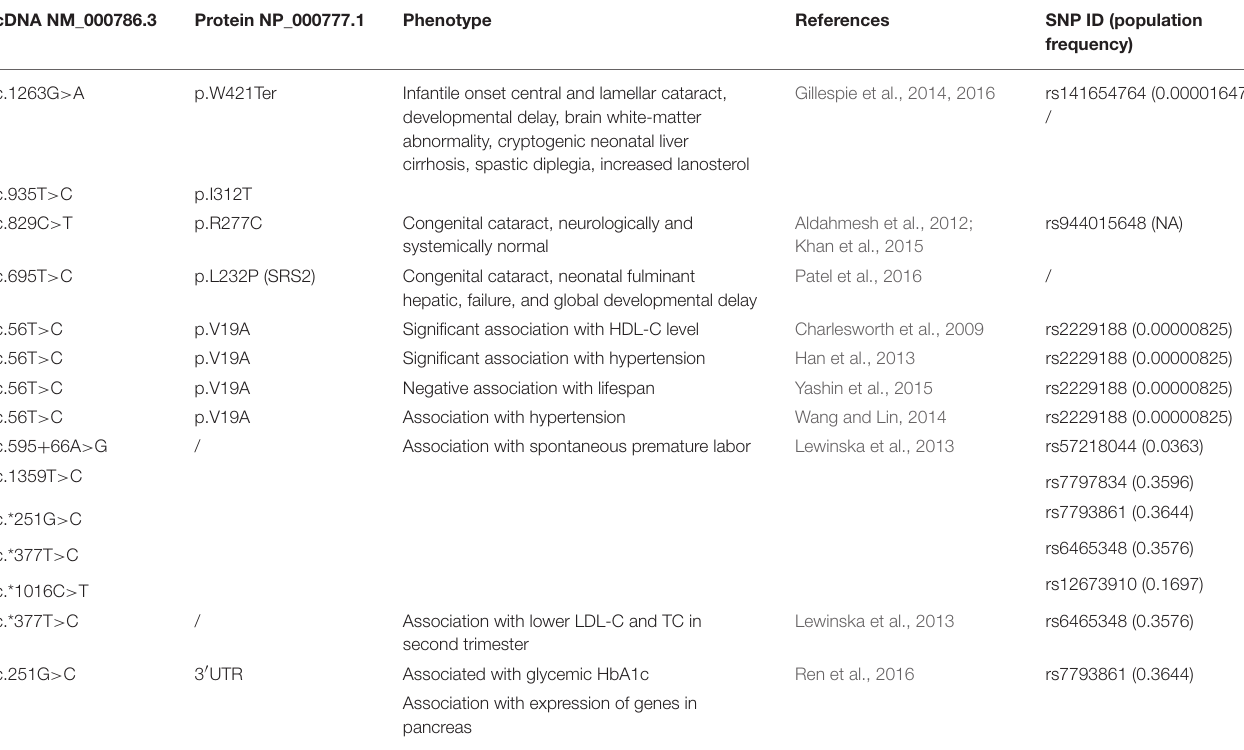
TABLE 1 | CYP51A1 polymorphisms associated with phenotypes in humans and population frequency from 1,000 genomes. cDNA NM_000786.3 Protein